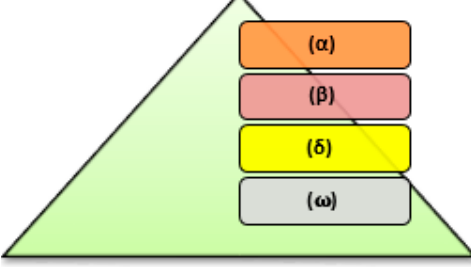
Figure 6. Hierarchy of grey wolves.